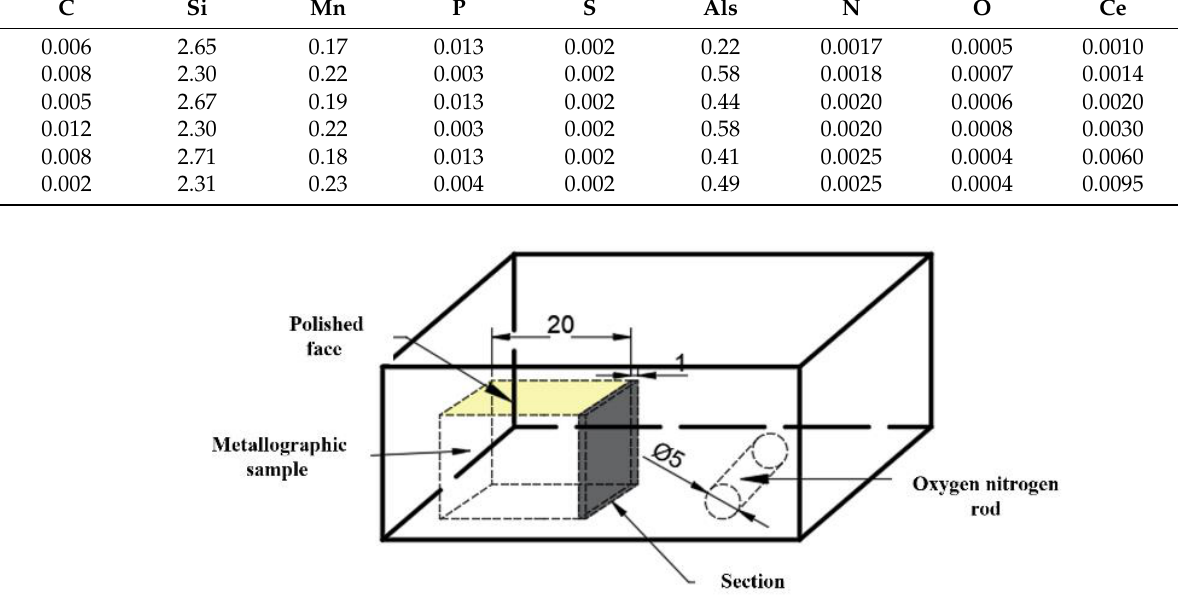
Table 3. Chemical composition of experimental steel (wt.%).